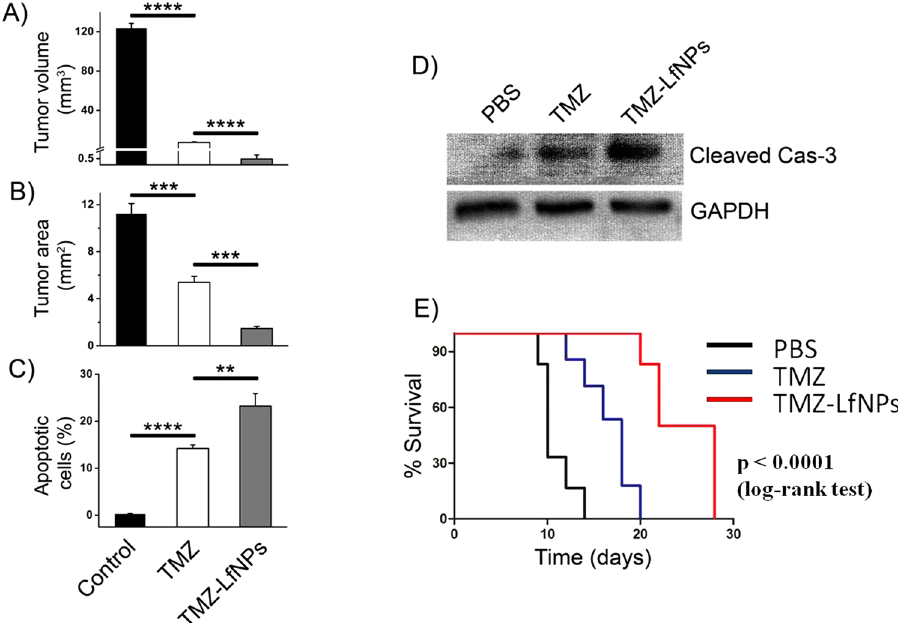
Figure 7. Tumor volume (A) and tumor area (B) in untreated mice (black bar) and mice treated with TMZ (white bar) and TMZ-LfNPs (grey bar). (C) Quantification of apoptosis in untreated mice (black bar) and mice treated with TMZ (white bar) and TMZ-LfNPs (gray bar). (n = 3, ** p < 0.01, *** p < 0.001, **** p < 0.0001. (D) Western blot of cleaved Caspase-3 in representative tumor lysates. GAPDH is used as a loading control. Full length blot has been given in Supplementary Information (E) Kaplan-Meier survival curve; comparison of survival in glioma bearing mice treated with: PBS (black curve), TMZ (blue curve) and TMZ-LfNPs (red curve). No of animals per treatment group =